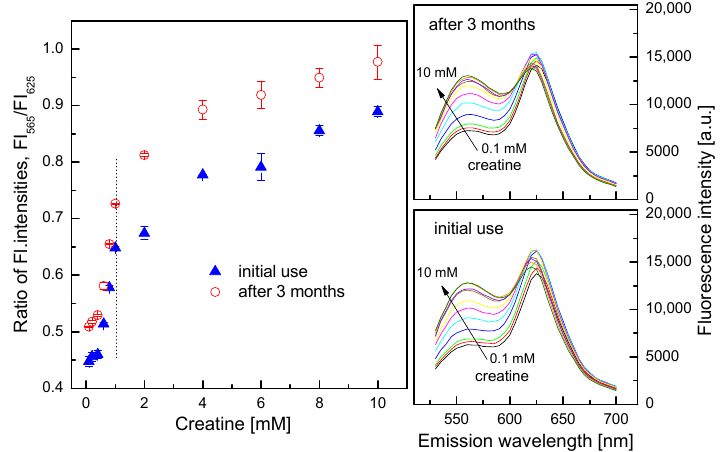
Figure 4. Long-term stability of the creatine-sensing membrane in the presence of creatine 0.1 to 10 mM creatine upon initial use and after 3 months of use ( left ), and two fluorescence emission spectra of the creatine-sensing membrane with respect to creatine concentrations at λ ex = 460 nm.